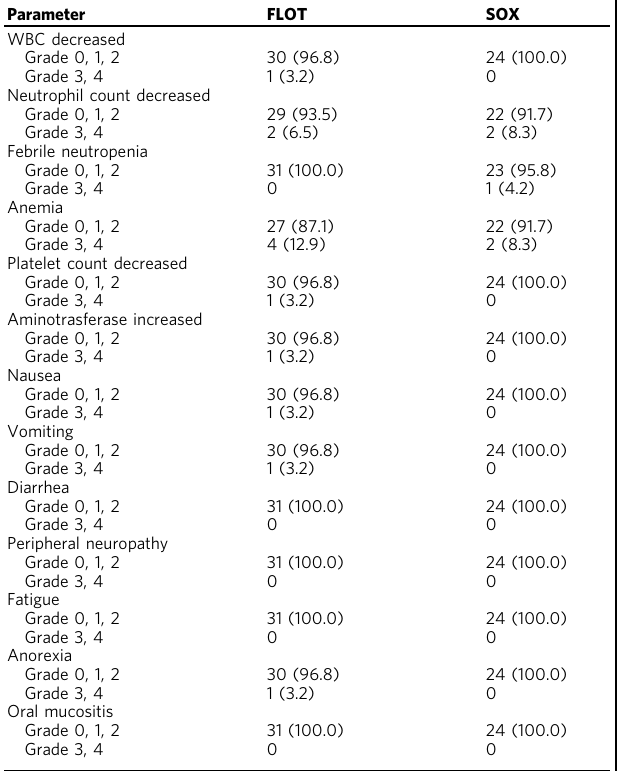
Analysis of per-protocol population except otherwise